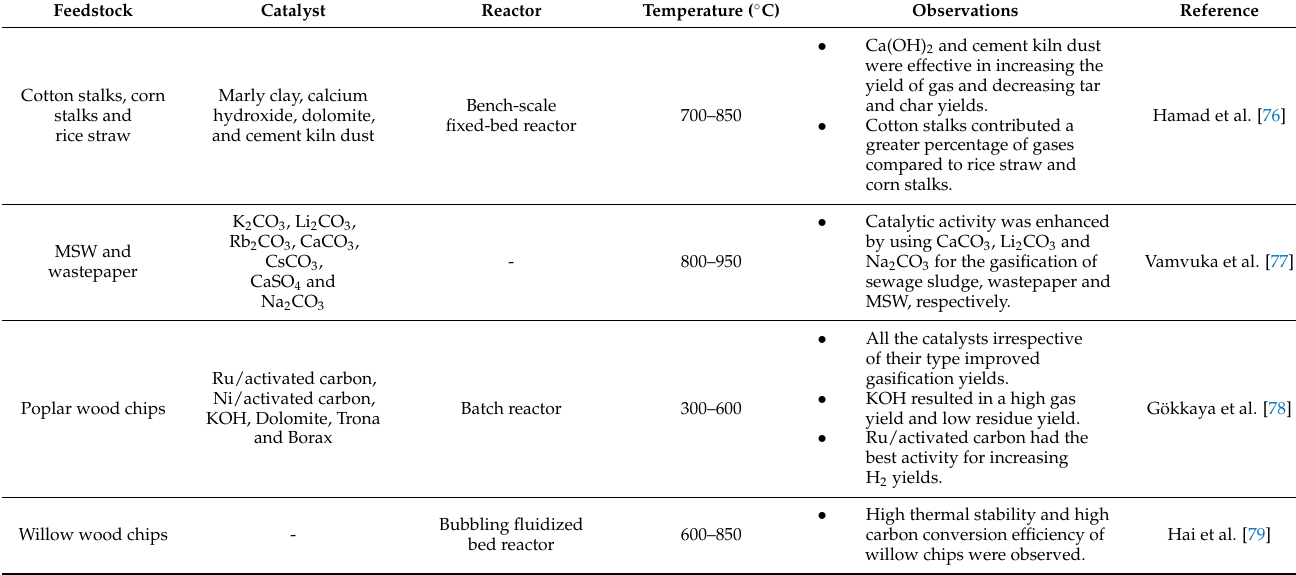
Table 5. Summary of notable works on gasification of waste